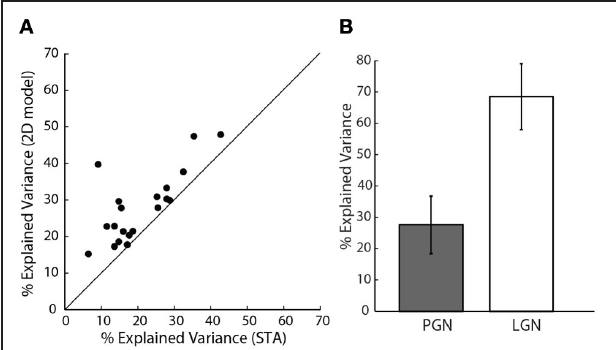
FIGURE 7 | Assessing model performance using explained variance. (A) Explained variance for the 2D vs. 1D model, all the points lie above the line of unity slope. ( n = 20). (B) Comparison of explained variance for 1D models of cells in the PGN ( n = 20), shaded, and a randomly selected sample of cells in LGN ( n = 10),